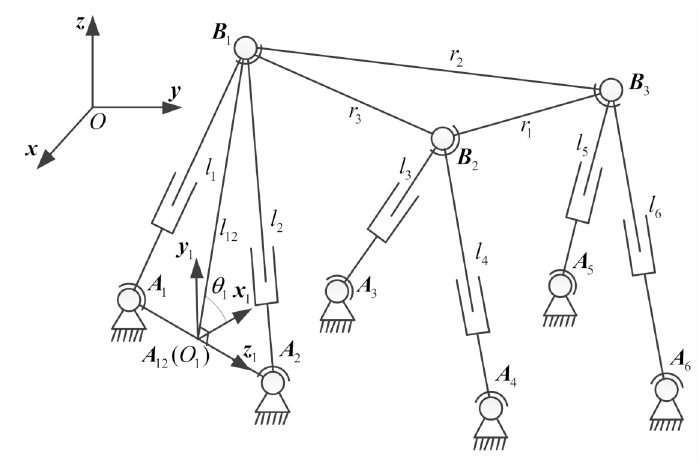
Figure 1. The structure of 6-3 Stewart